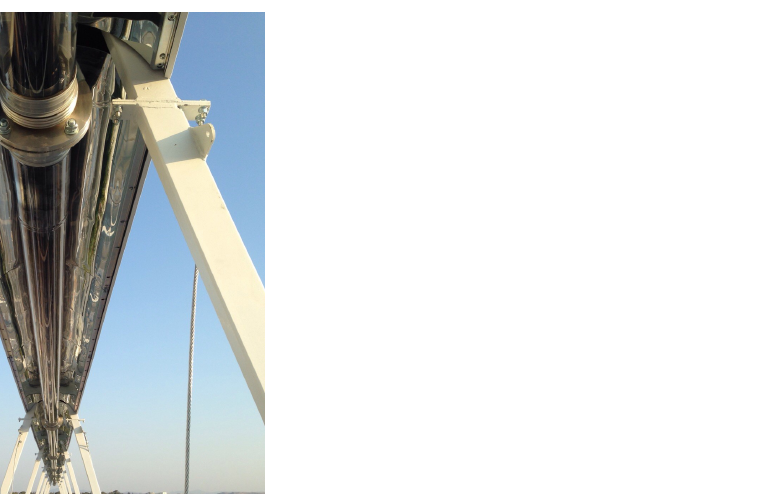
Figure 3. Receiver of the LFC, 32 m long with eight evacuated tubes in